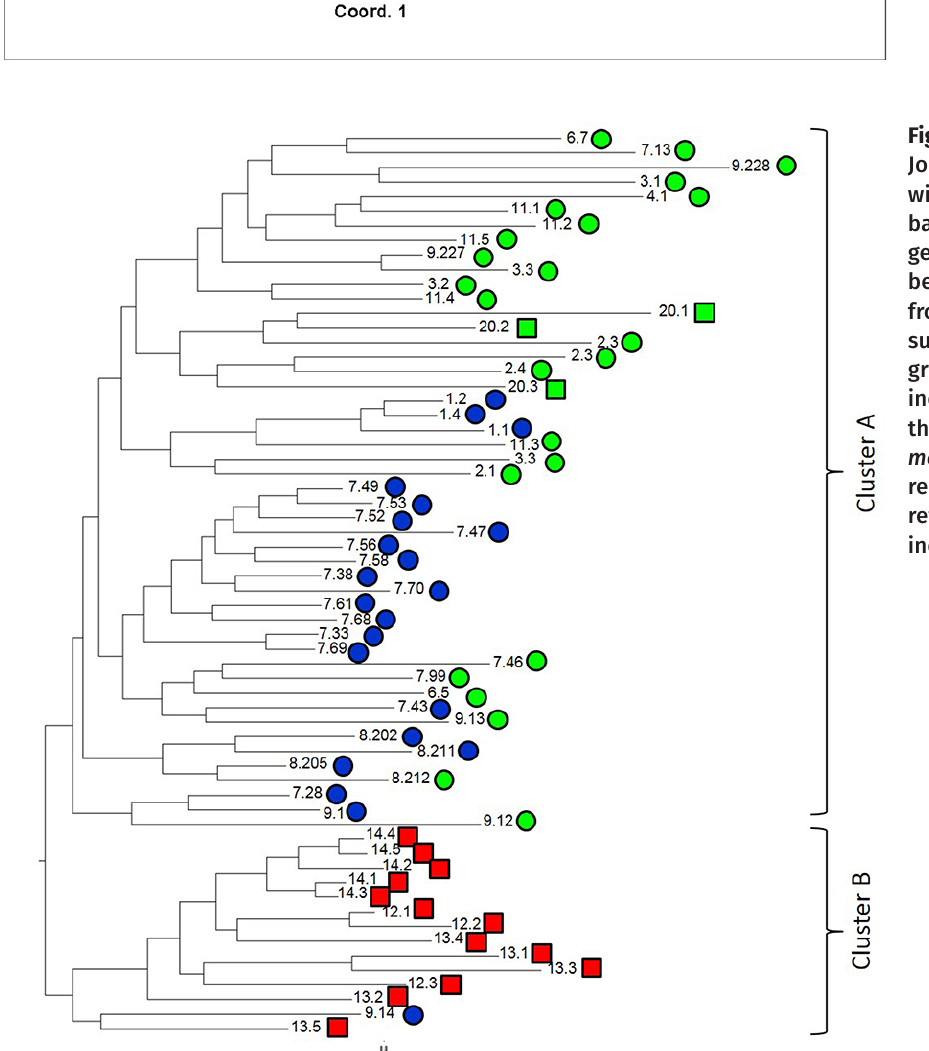
Figure 6. Principal coordinates analysis ordination plot of the sample points in the plane of the first two principal axes based on RAPD data of plants of Turnera sidoides subsp. carnea . Colors indicate Bayesian groups resulted from STRUCTURE analysis. Red symbols: Bayesian group I; green symbols: Bayesian group II, and blue symbols: Bayesian group